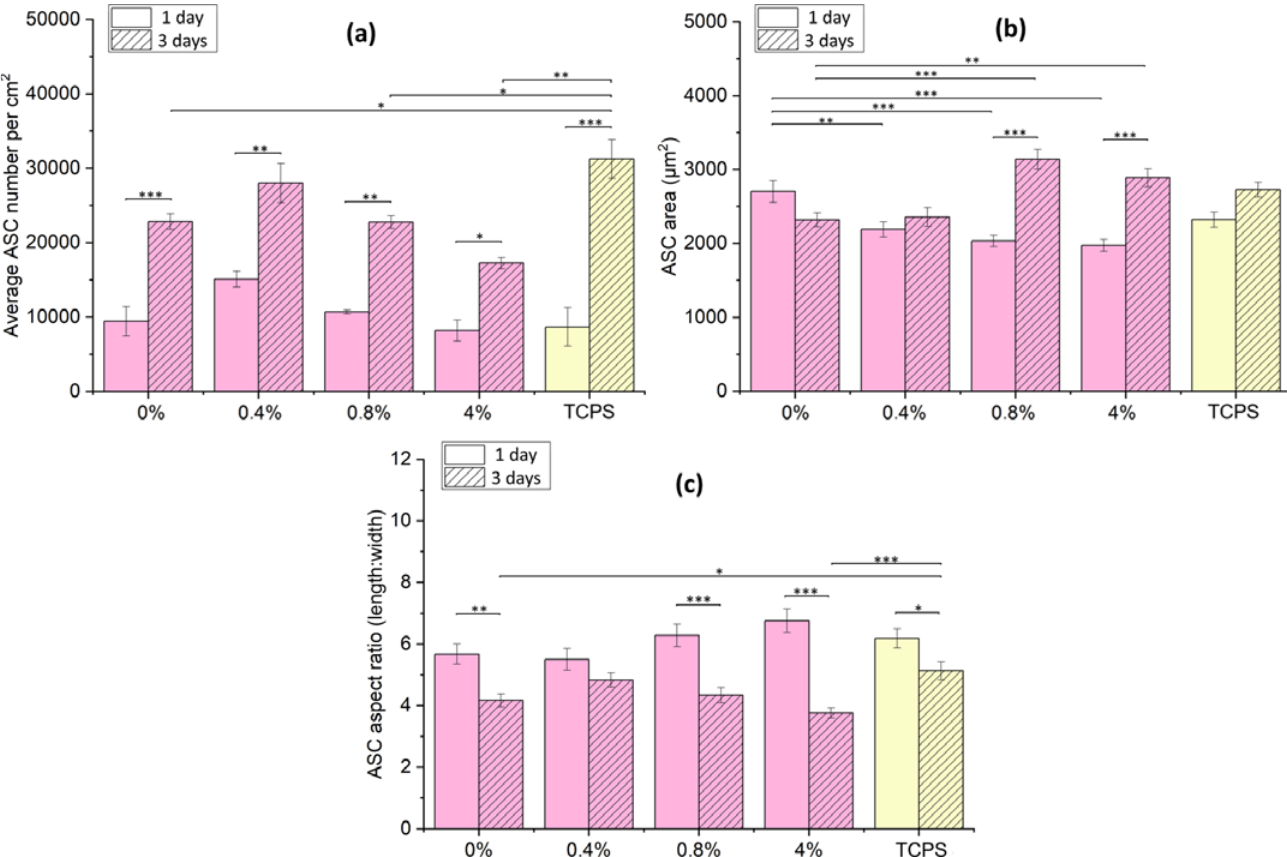
Figure 7. ASCs cultured for 1 and 3 days on unmodified cPOC (0 wt.%) , on cPOC modified with different concentrations of GSH (0.4, 0.8 and 4 wt.%) and on TCPS: average cell number per cm 2 ( a ), average cell spreading area ( b ) and cell aspect ratio ( c ). Mean ± SE, statistically significant differences at * p < 0.05, ** p < 0.01, and *** p < 0.001.